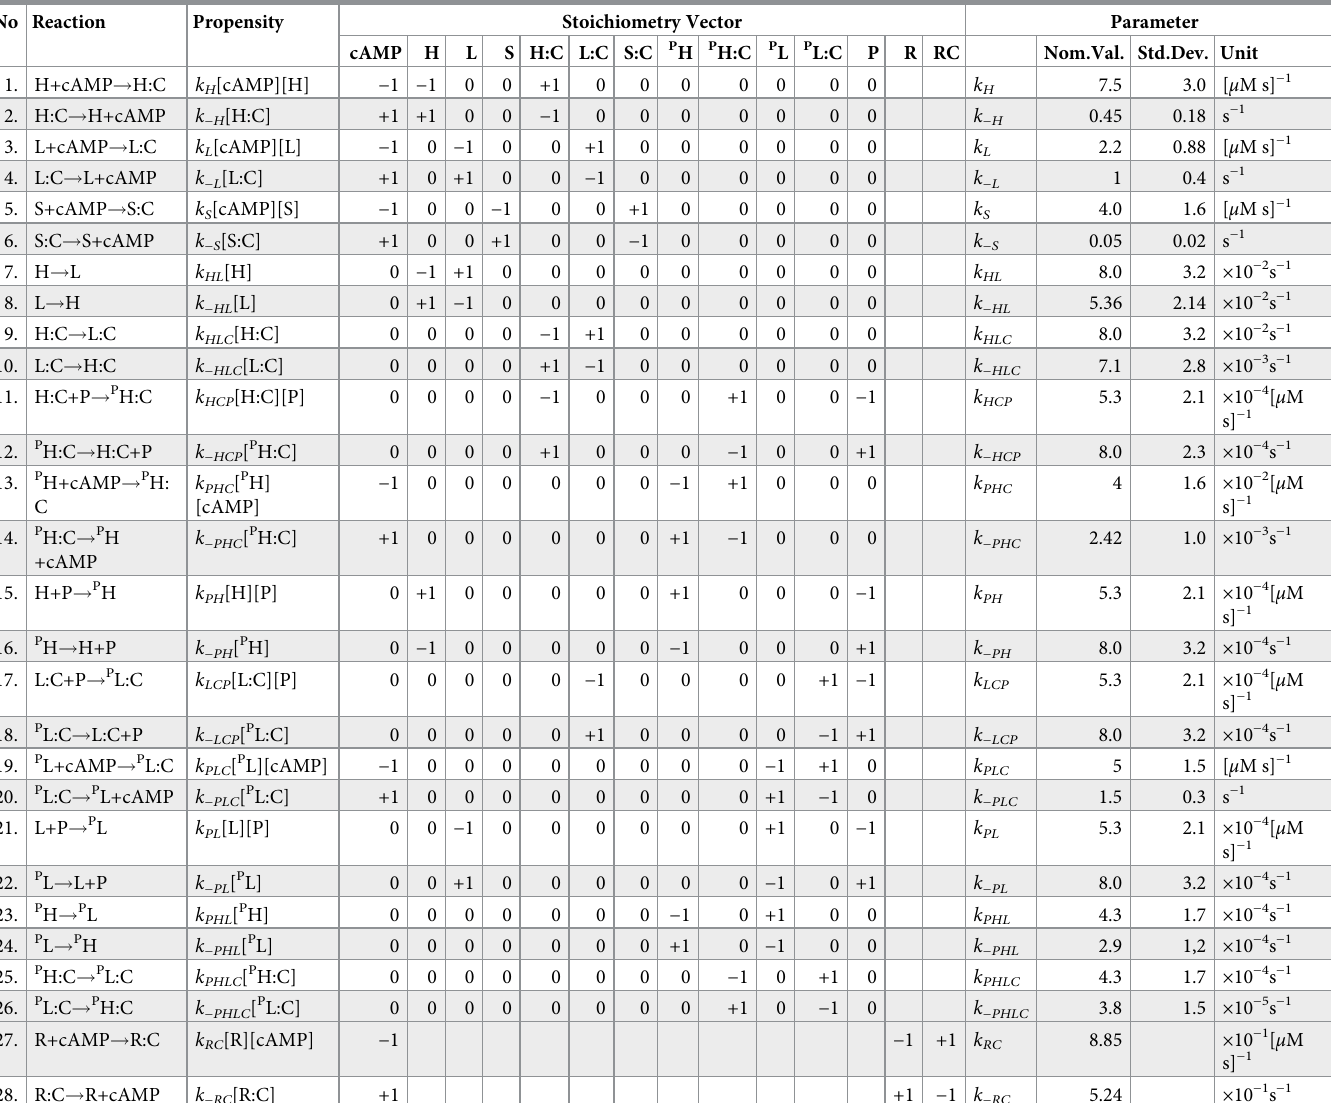
Table 1. Parameters for G-protein-coupled receptor (GPCR) module with propensity and stoichiometry vectors. Parameter values for reaction no. 1–10 are from [42]; for reaction no. 11–26, the values were estimated to match the experimental observations from [43, 44]; for reaction no. 27–28, the values were obtained by minimizing the difference between the responses of full- and reduced-order system. The diffusion constants for all the GPCRs are assumed to be 2.7 × 10 − 2 μ m 2 s − 1 [45]. The total number of receptor molecules followed a Gaussian distribution with mean and standard deviation of 70,000 and 5,000 molecules,